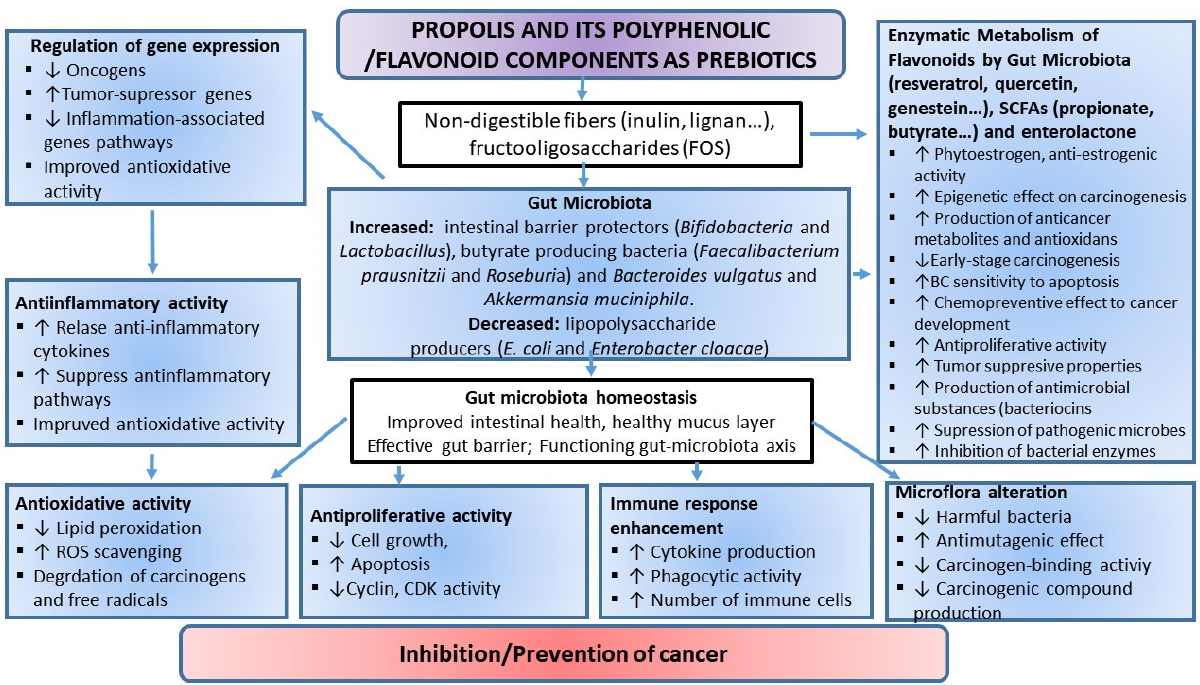
Figure 4. Interaction between propolis and its polyphenolic/flavonoid components and the intestinal microbiota. Propolis and its components exert a positive effect on the intestinal microbiota, leading to the establishment of intestinal homeostasis through improved gut health, healthy mucus layer, effective intestinal barrier, and functional gut – microbiota axis. The bioavailability and impact of polyphenols on the host greatly depend on their transformation by specific components of the gut microbiota. Acting as prebiotics, propolis and its polyphenolic/flavonoid components stimulate the immune system, reducing inflammatory responses and oxidative stress.